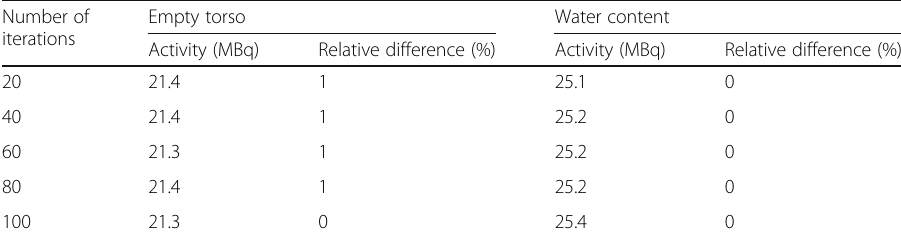
Table 3 Estimated myocardial activities and relative differences between the estimated and